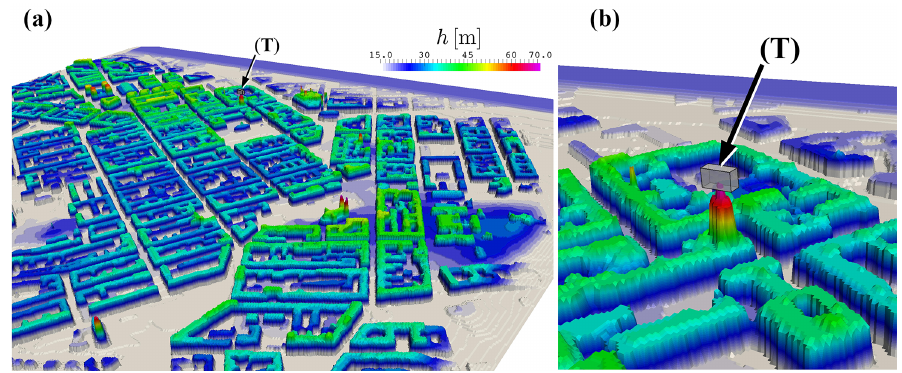
Figure 3. A three-dimensional rendering of the urban topography near Hotel Torni (a) and a close-up featuring the target box (T) for particle capturing (b) .